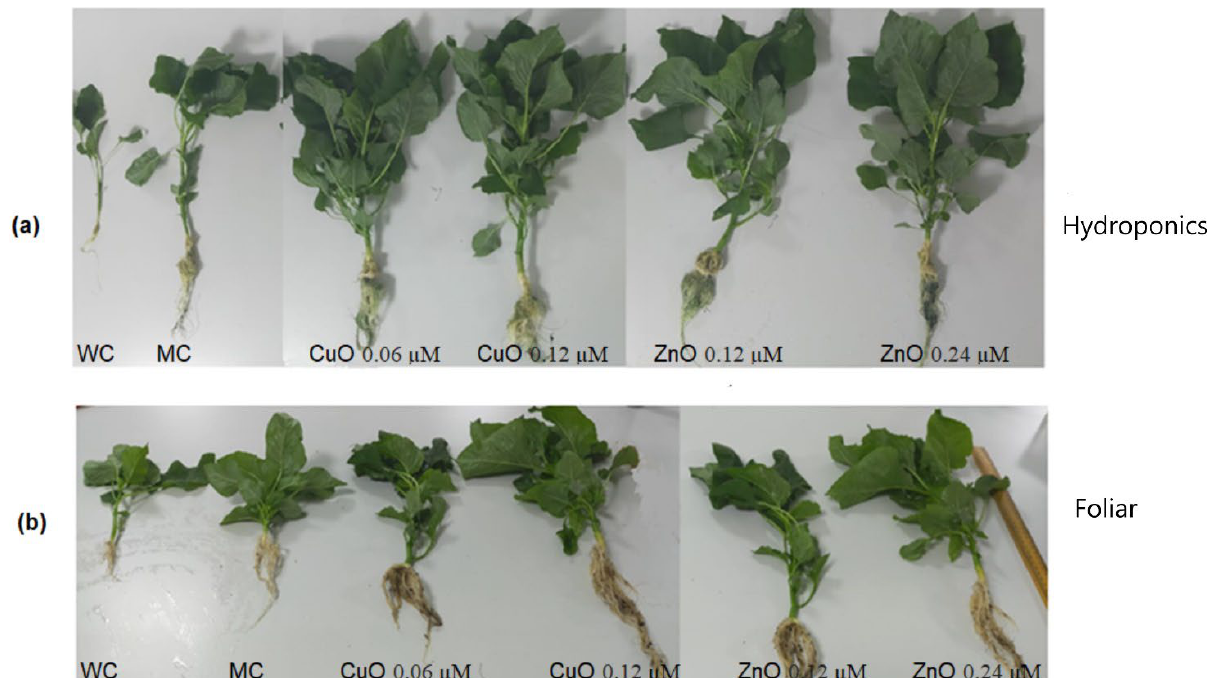
Figure 7. Phenotypic representation of Amaranthus hybridus plants treated with varying concentra- tions of CuO and ZnO nanoparticles (0.06 µM CuO, 0.12 µM CuO, 0.12 µM ZnO, and 0.24 µM ZnO) ( a ) in hydroponics setup and ( b ) foliar application. A water control (WC) and media control (MC) were maintained. Table 2. Effect of the application of CuO and ZnO nanoparticles through hydroponic and foliar systems on the phenotypic character of Amaranthus hybridus plantlets. Foliar